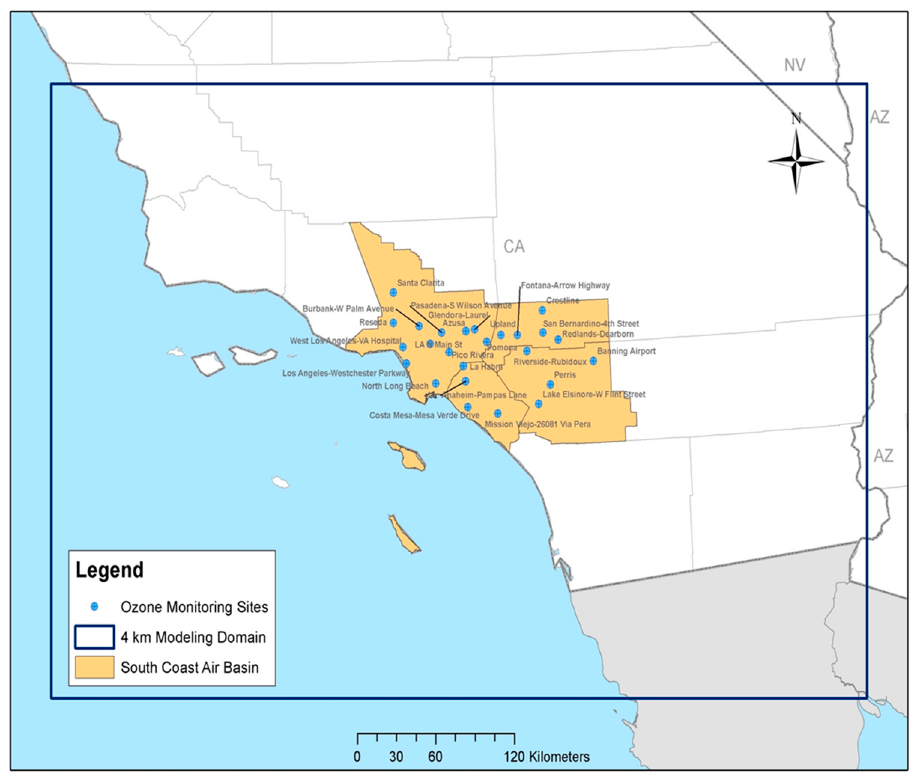
Figure 1. Modeling domain with locations of ozone monitors in the South Coast Air Basin.